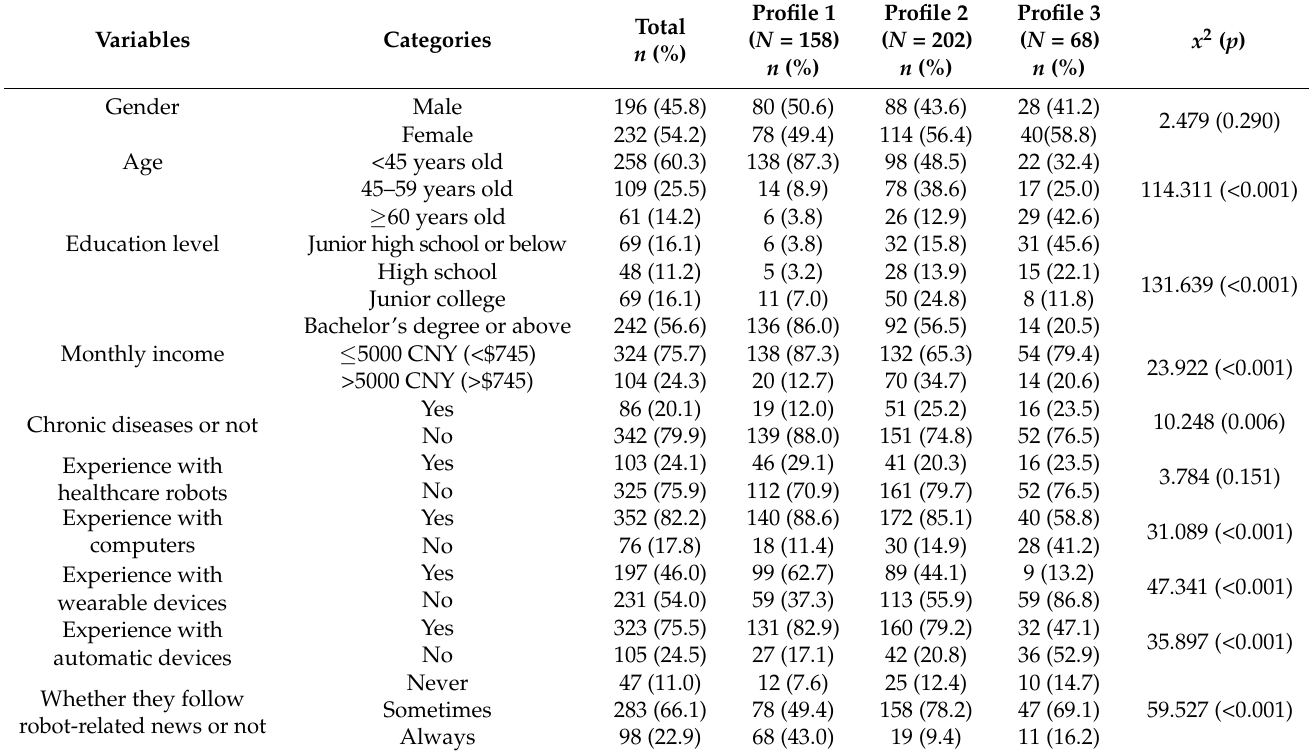
Table 1. Demographic characteristics of the three